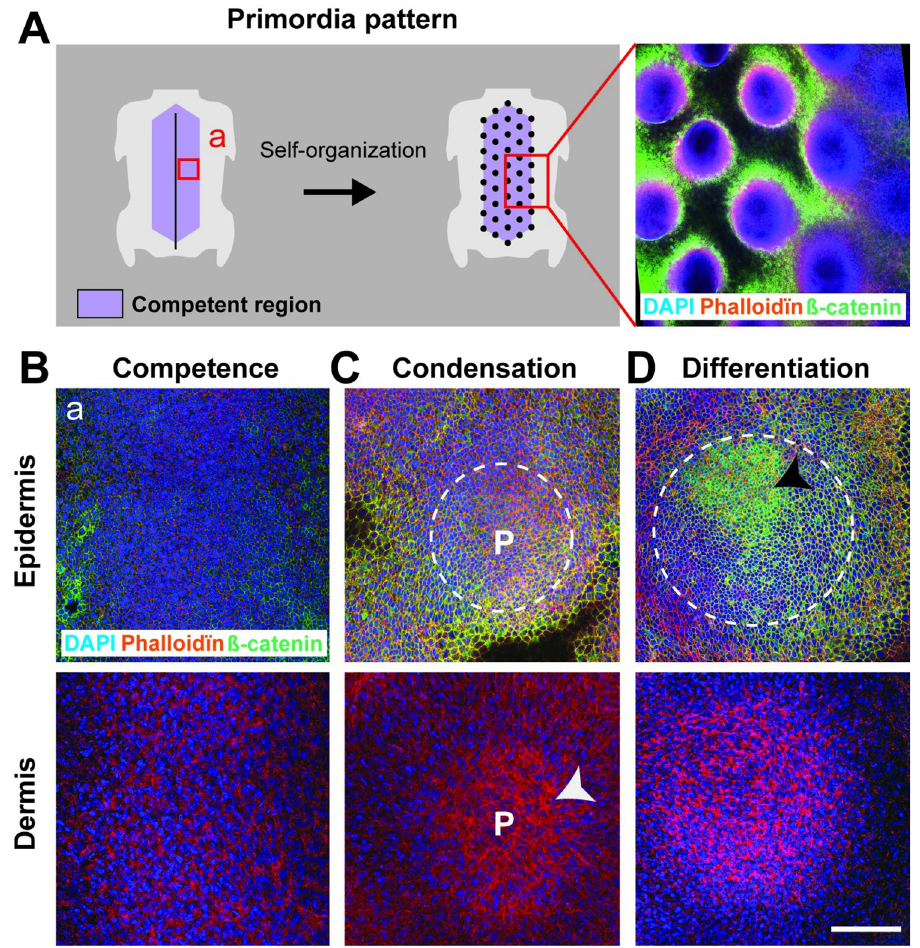
Fig 1. Self-organized primordia patterning in the avian skin. (A) Left panel: Competent regions (in purple) in birds’ dorsal skin form primordia arrays (black dots) through cellular self-organization. Right panel: The primordia pattern was visible on a 10 × confocal view (corresponding to the red square in the left panel) of a DAPI (in blue), β -catenin (in green), and phallo ï din (in red) stain in the Japanese quail embryonic skin. (B–D) The 40 × confocal views at the position of the red square in A (noted a) and oriented antero-posteriorly show developing primordia. Prior to pattern formation (competence stage; B), epidermal and dermal cells are homogeneously distributed. Cells then compact locally (condensation stage; C), forming nascent primordia (P, white dotted lines in epidermal views, arrowheads in dermal views). Primordia initiate programs of feather production (differentiation stage; D) upon nuclear translocation of β -catenin in epidermal nuclei (which occurs initially in the anterior part of primordia; black arrow). Scale bars: 100 μ m. as readily round shapes marked by the spatial restriction of ß-catenin expression, forming a longitudinal dotted line, or primordia row. New rows were gradually juxtaposed laterally in a sequential wave, as previously described [23,26,33]. When ß-catenin translocated in epidermal nuclei within the first-formed primordia, marking the onset of their differentiation stage, at least 3 rows were visible, together producing the hexagonal motif typical of the feather follicle pattern of these species [23,26]. By contrast, in the emu Dromaius novaehollandiae and the ostrich Struthio camelus , both part of the ancestral-most group Paleognathae , initial competent regions were 2 wide ß-catenin- expressing areas on each side of the dorsal midline. The firsts primordia emerged visibly simultaneously in budding shapes distributed in wavy oblique lines. They progressively acquired rounder shapes, together producing a spatially random